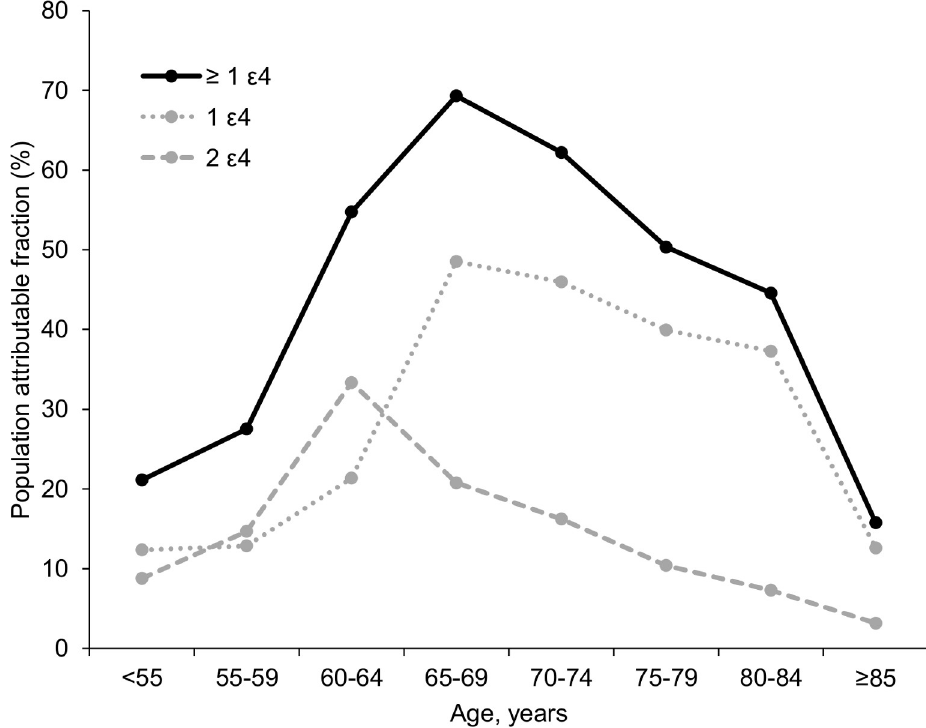
Fig 3. Population attributable fraction of APOE ε 4 for AD by 5-year age group. AD, Alzheimer disease; APOE , apolipoprotein E.